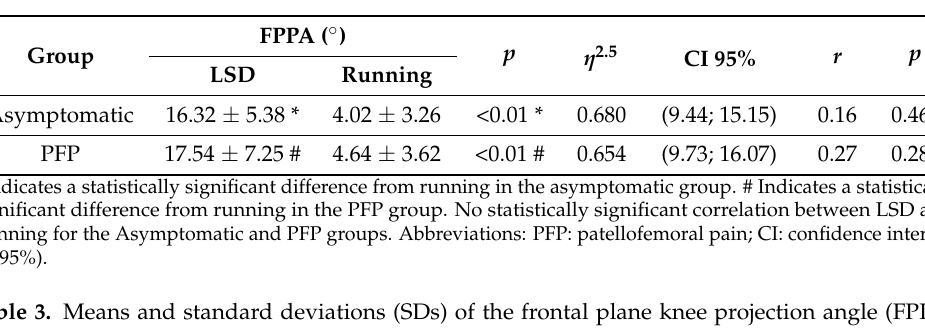
Table 2. Means and standard deviations (SDs) of the frontal plane knee projection angle (FPPA). Comparison and correlation between the LSD test and running in the two groups. Eta-squared ( η 2 ) and Pearson’s correlation coefficient ( r ).